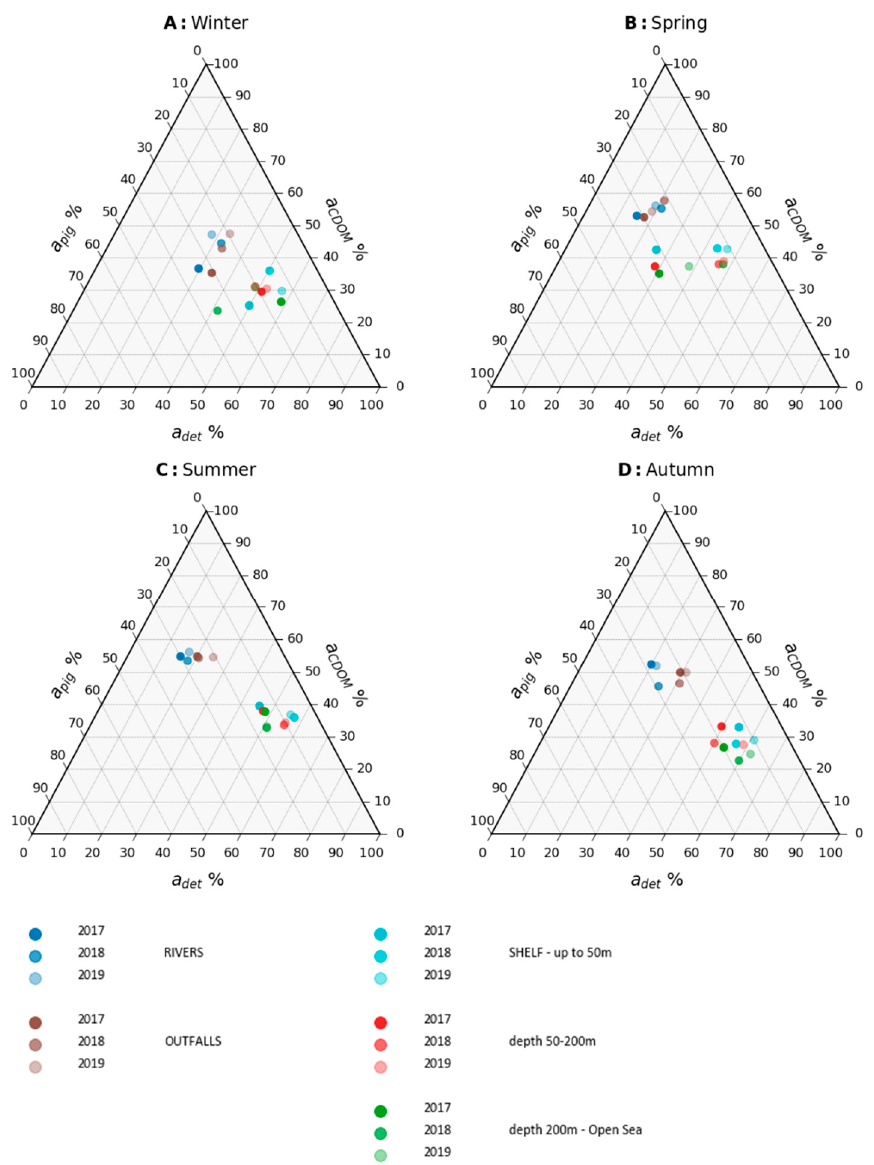
Figure 7. Ternary diagrams of the seasonal and annual means for all five groups. The percent contribution of each of the three IOPs to the total absorption at 443 nm is plotted on the three axes. The mean value of each group is plotted for each of the years 2017–2019. The legend below gives the color code for each group and year.